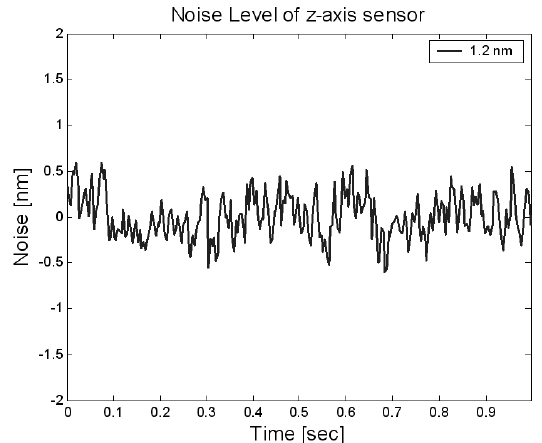
Figure 9. Noise level of the z -scanner.